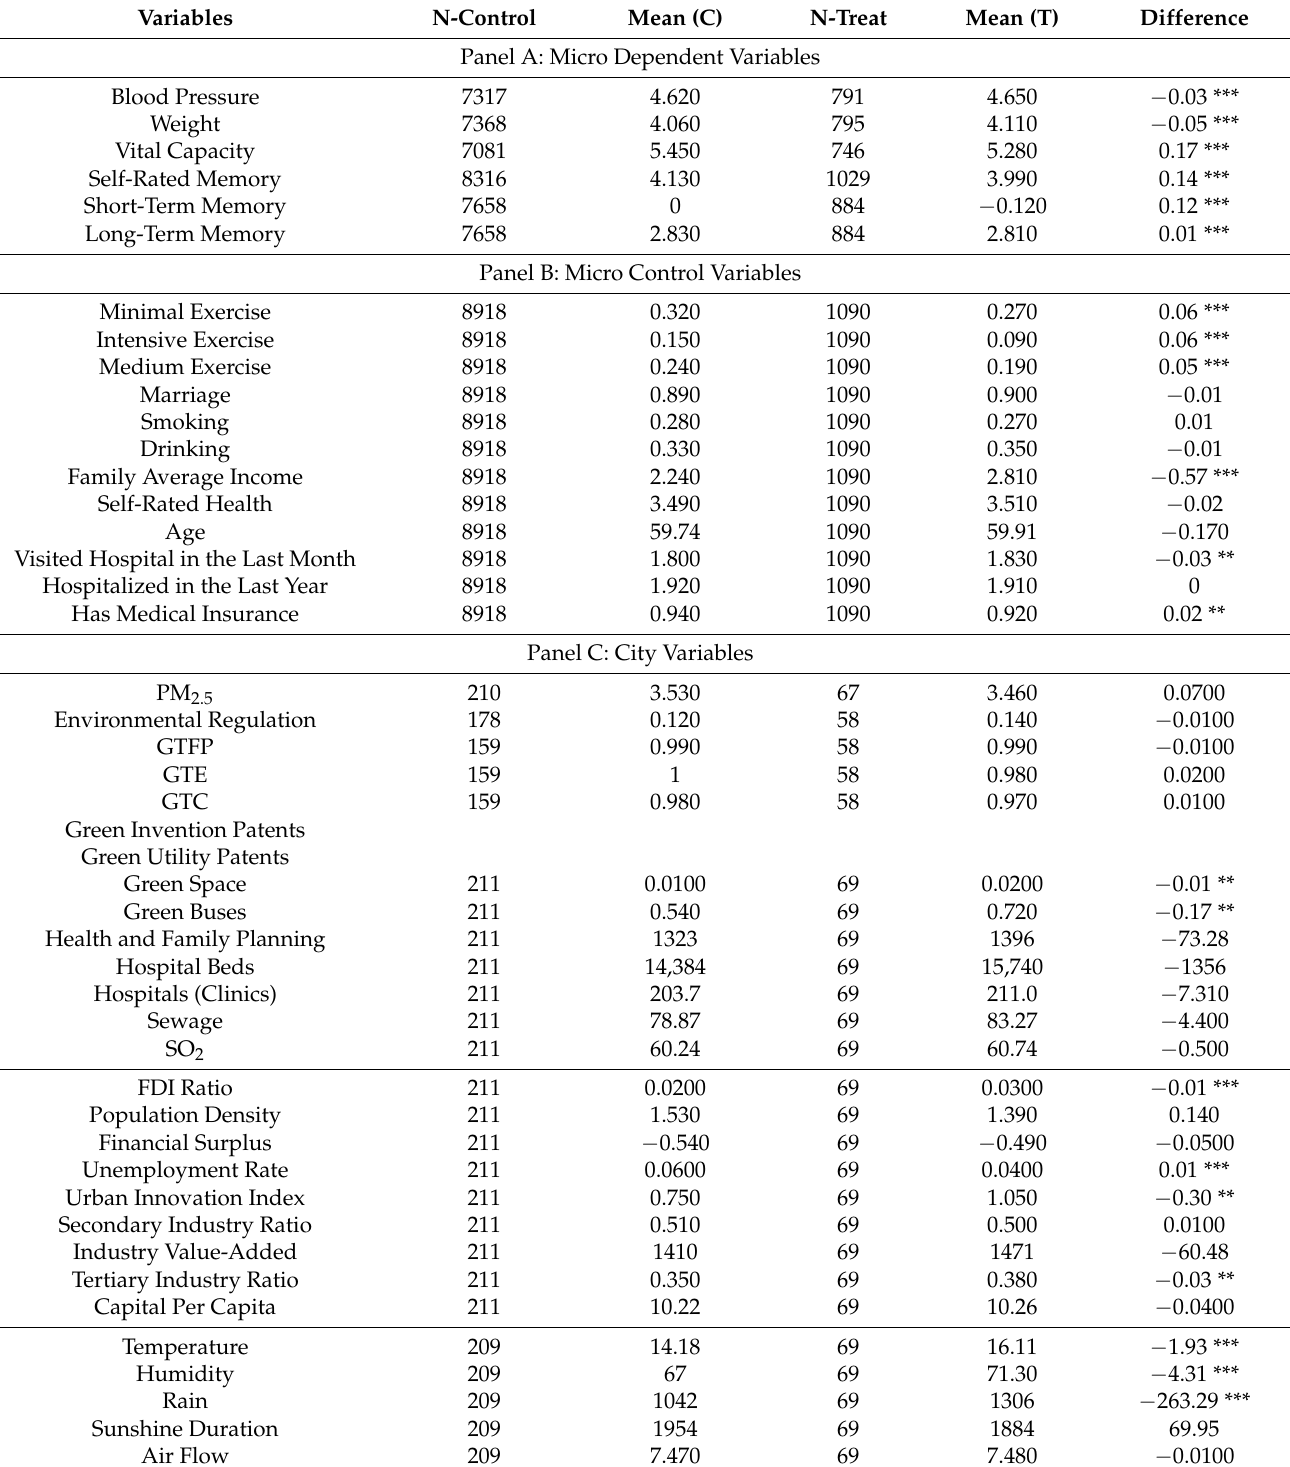
Table 2. Testing for the difference of grouping means of